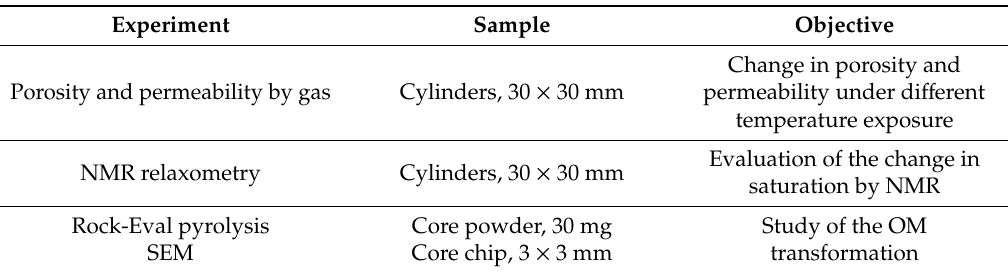
Table 2. Test design strategy.